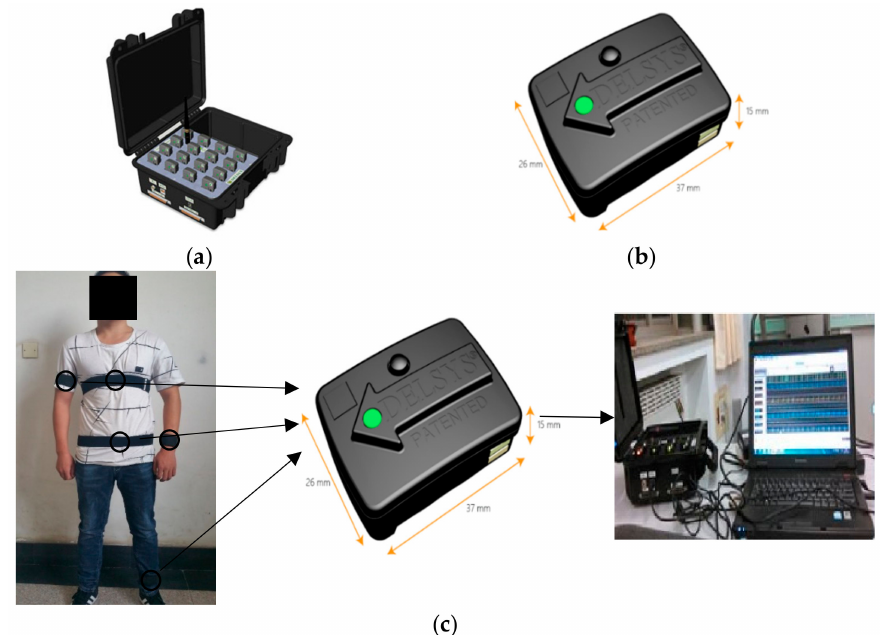
Figure 4. Human activity data acquisition platform based on acceleration sensor: ( a ) the data acquisition platform, ( b ) data collection node containing a triaxial accelerometer, ( c ) experimental data acquisition process.